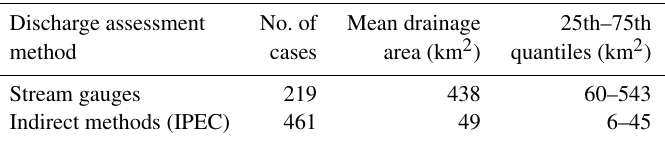
Table 3. Summary statistics for drainage areas for the EuroMedeFF database based on the two classes of discharge assessment (stream gauges vs. indirect